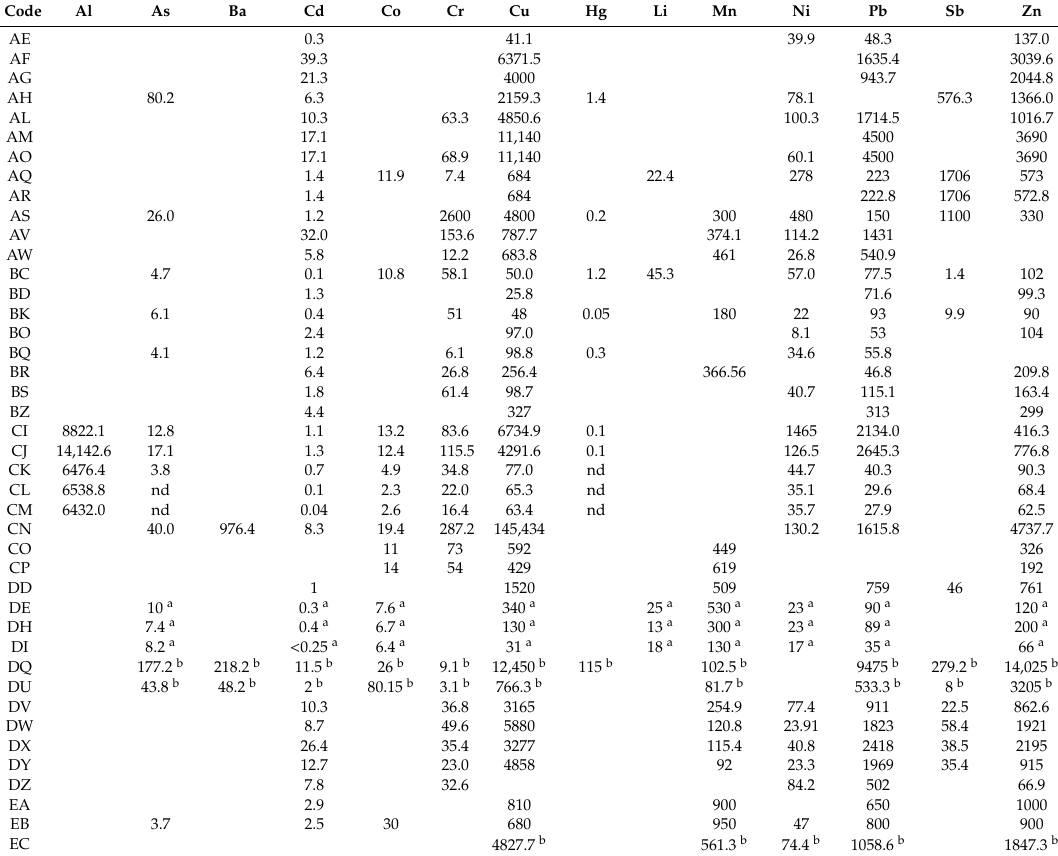
Table 2. Concentration of heavy metals and metalloids in soils (values expressed in mg / kg). Code